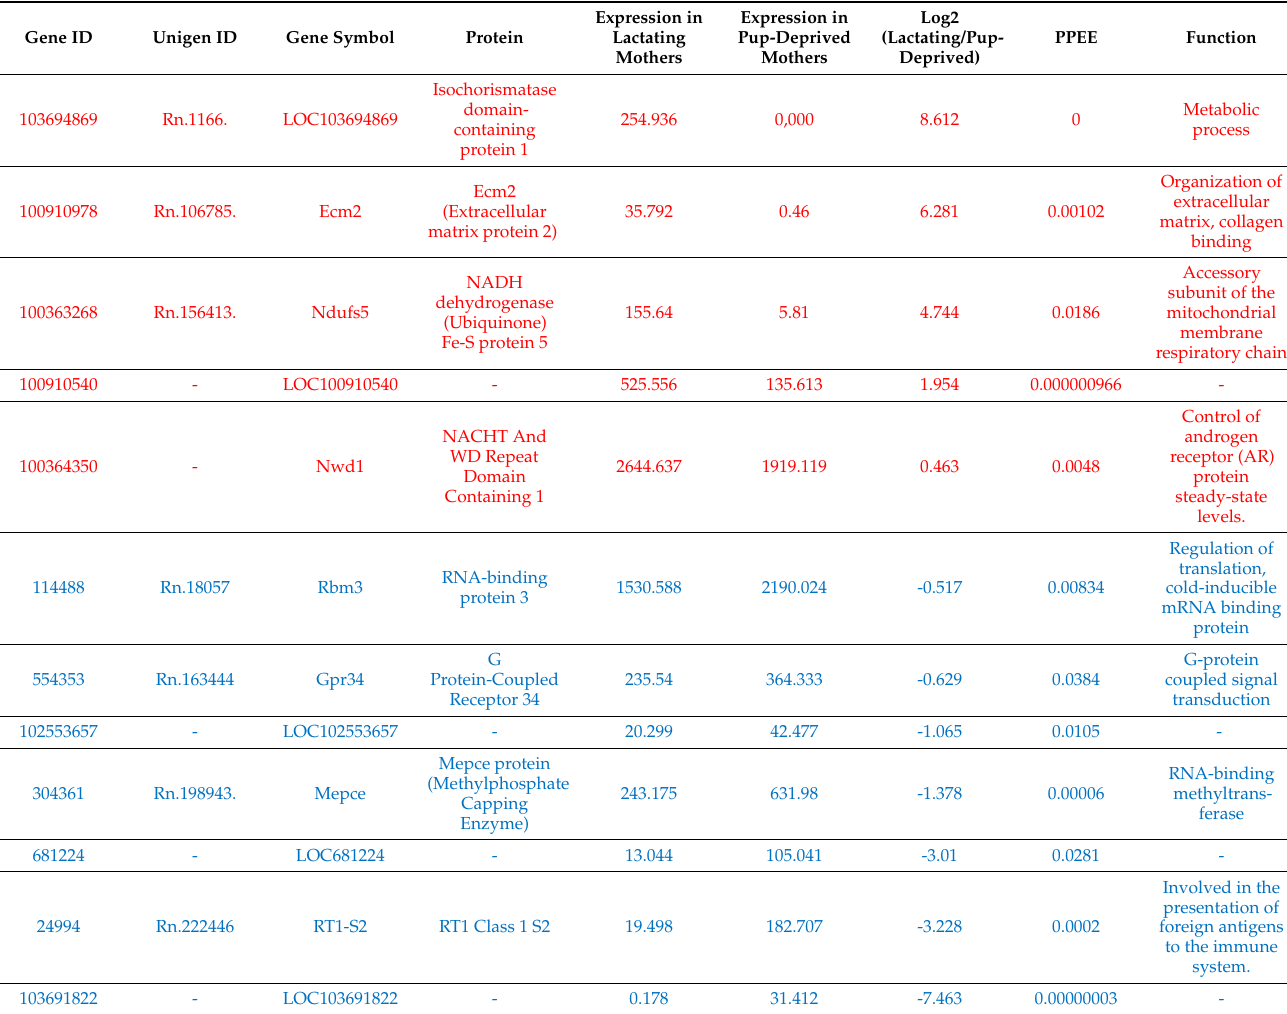
Table 2. Differentially expressed genes in the preoptic area of lactating and pup-deprived mothers. The genes with elevated expression in lactating mothers are shown in red and those with elevated expression in pup-deprived mothers are blue. The genes were filtered as differentially expressed genes if their log2 Fold Change was between − 0,4 and +0.4 and their PPEE (posterior probabilities of being equivalent expression) value were ≤